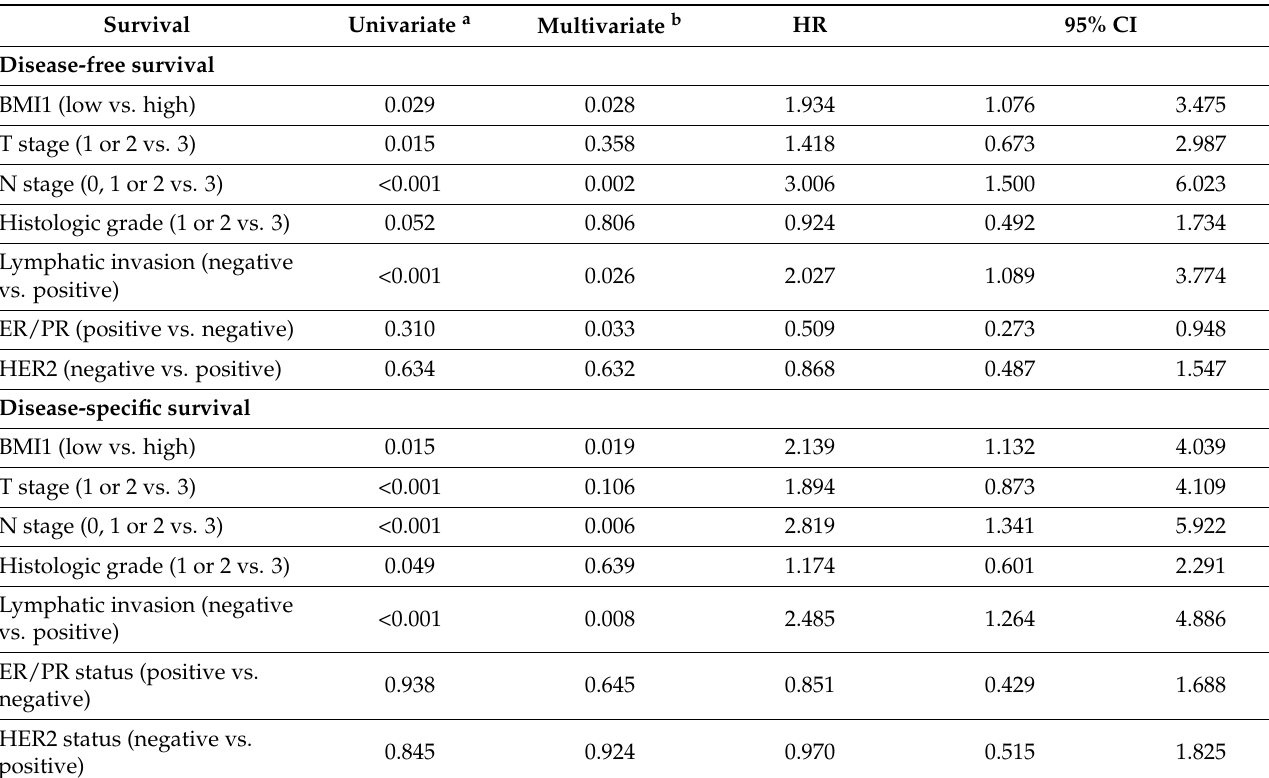
Table 2. Disease-free and disease-specific survival analyses of patients stratified by BMI1 expression.